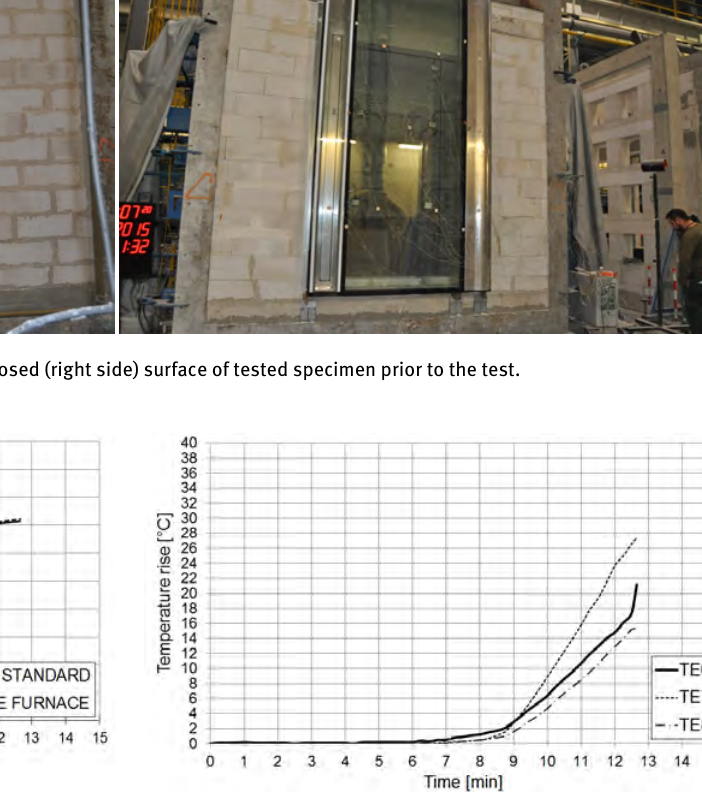
Figure 9: Graph of the temperature rises on unexposed surface of glass unit (thermocouples placed in the top of the glass unit).